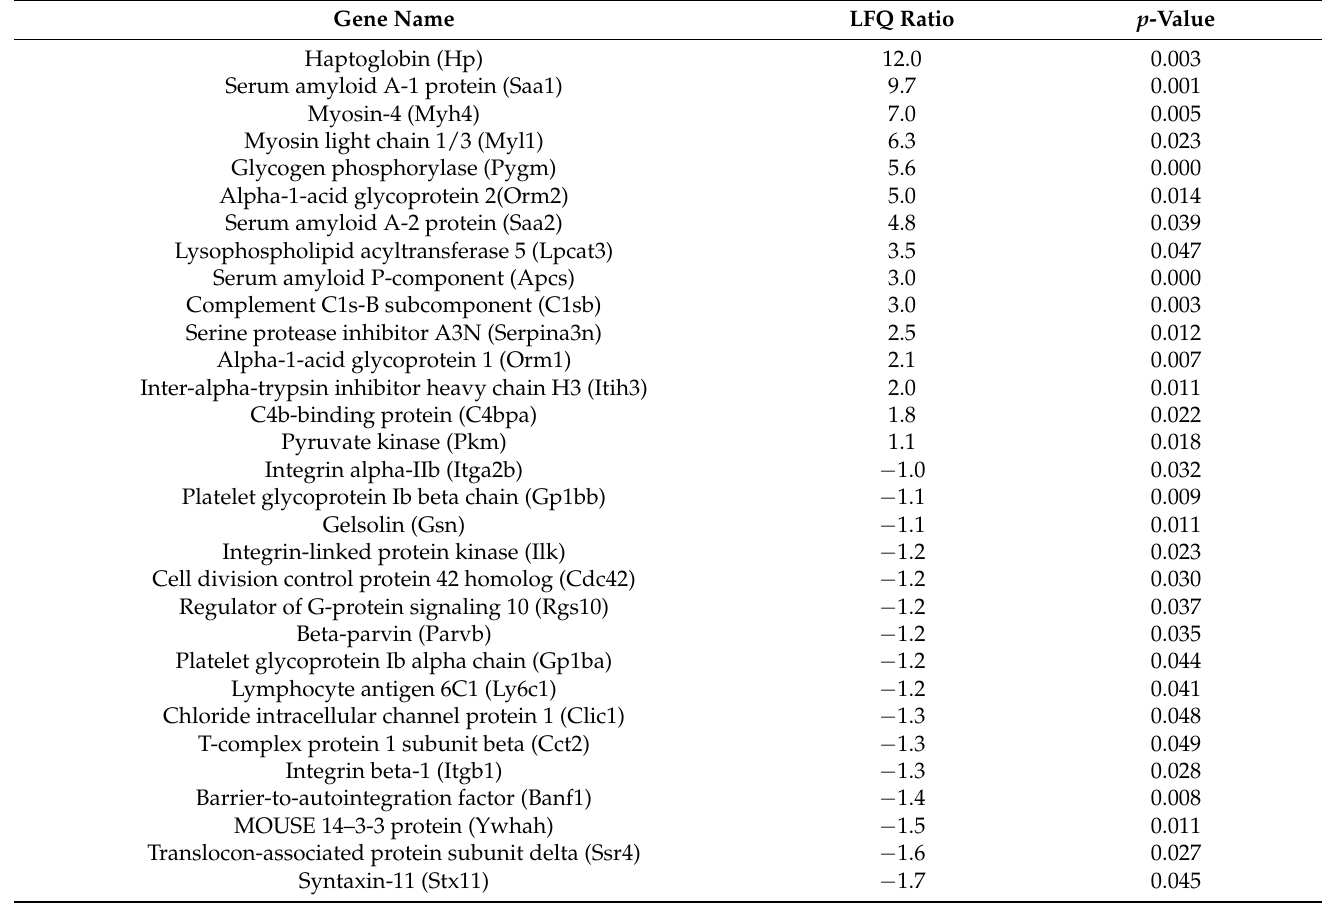
Table 1. Differentially expressed proteins in plasma EVs following 20% TBSA burn injury in mice by LC-MS/MS. Key: LFQ-Label-free